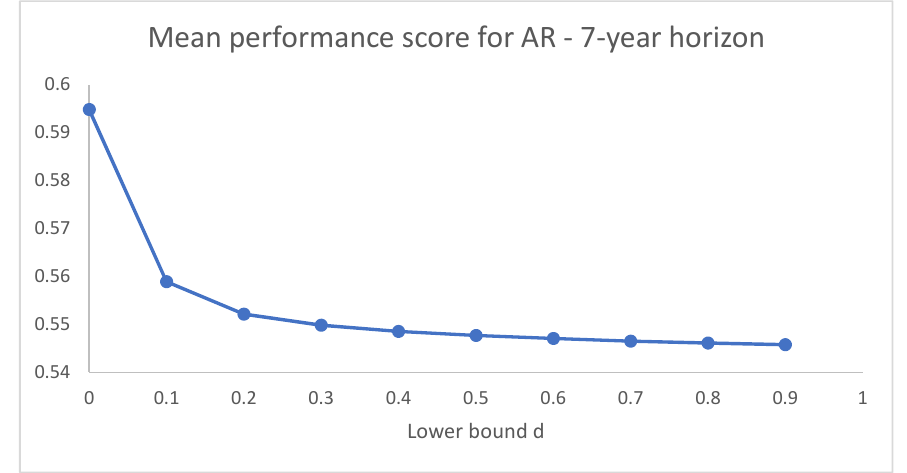
Figure 4. Dynamics of the mean performance scores of AR restrictions as d increases, for T = 7 and symmetric